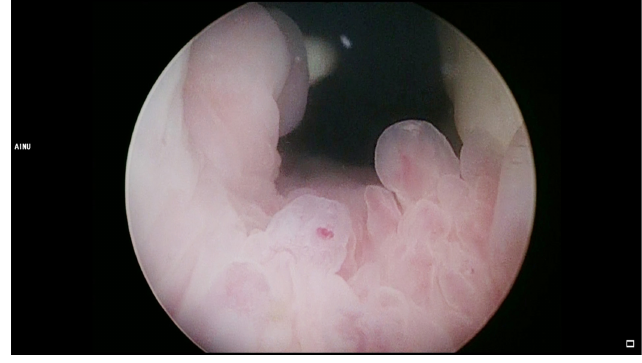
Figure 6. Vesico-ureteric anastomosis over a Double J stent.